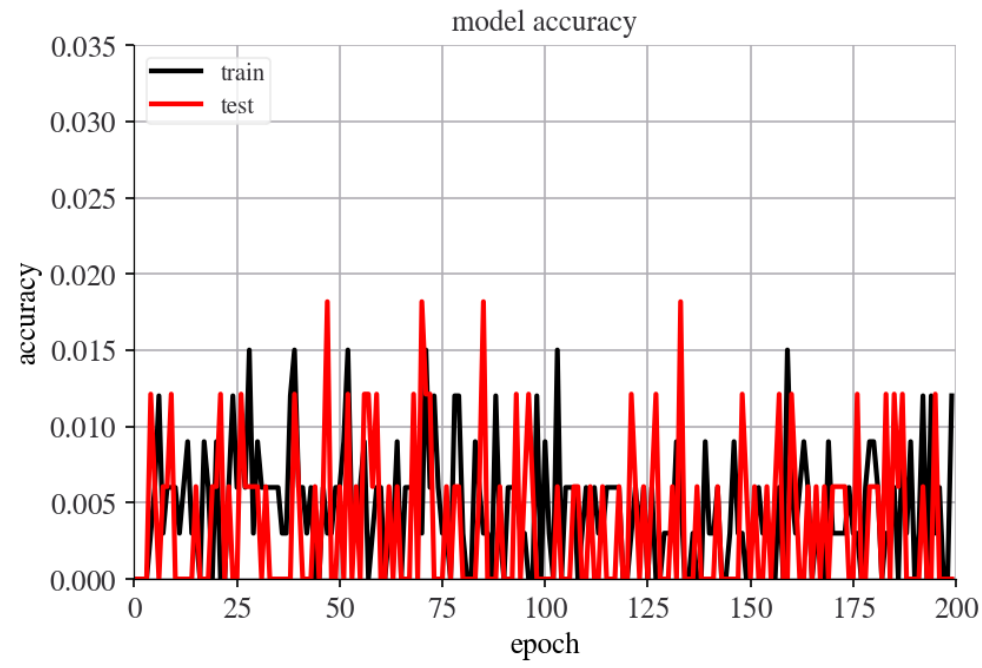
Figure 10. Prediction of the temperature reading using a simple multilayer perceptron model with a time lag, blue rep- resents the whole dataset, green represents training and orange represents predictions.